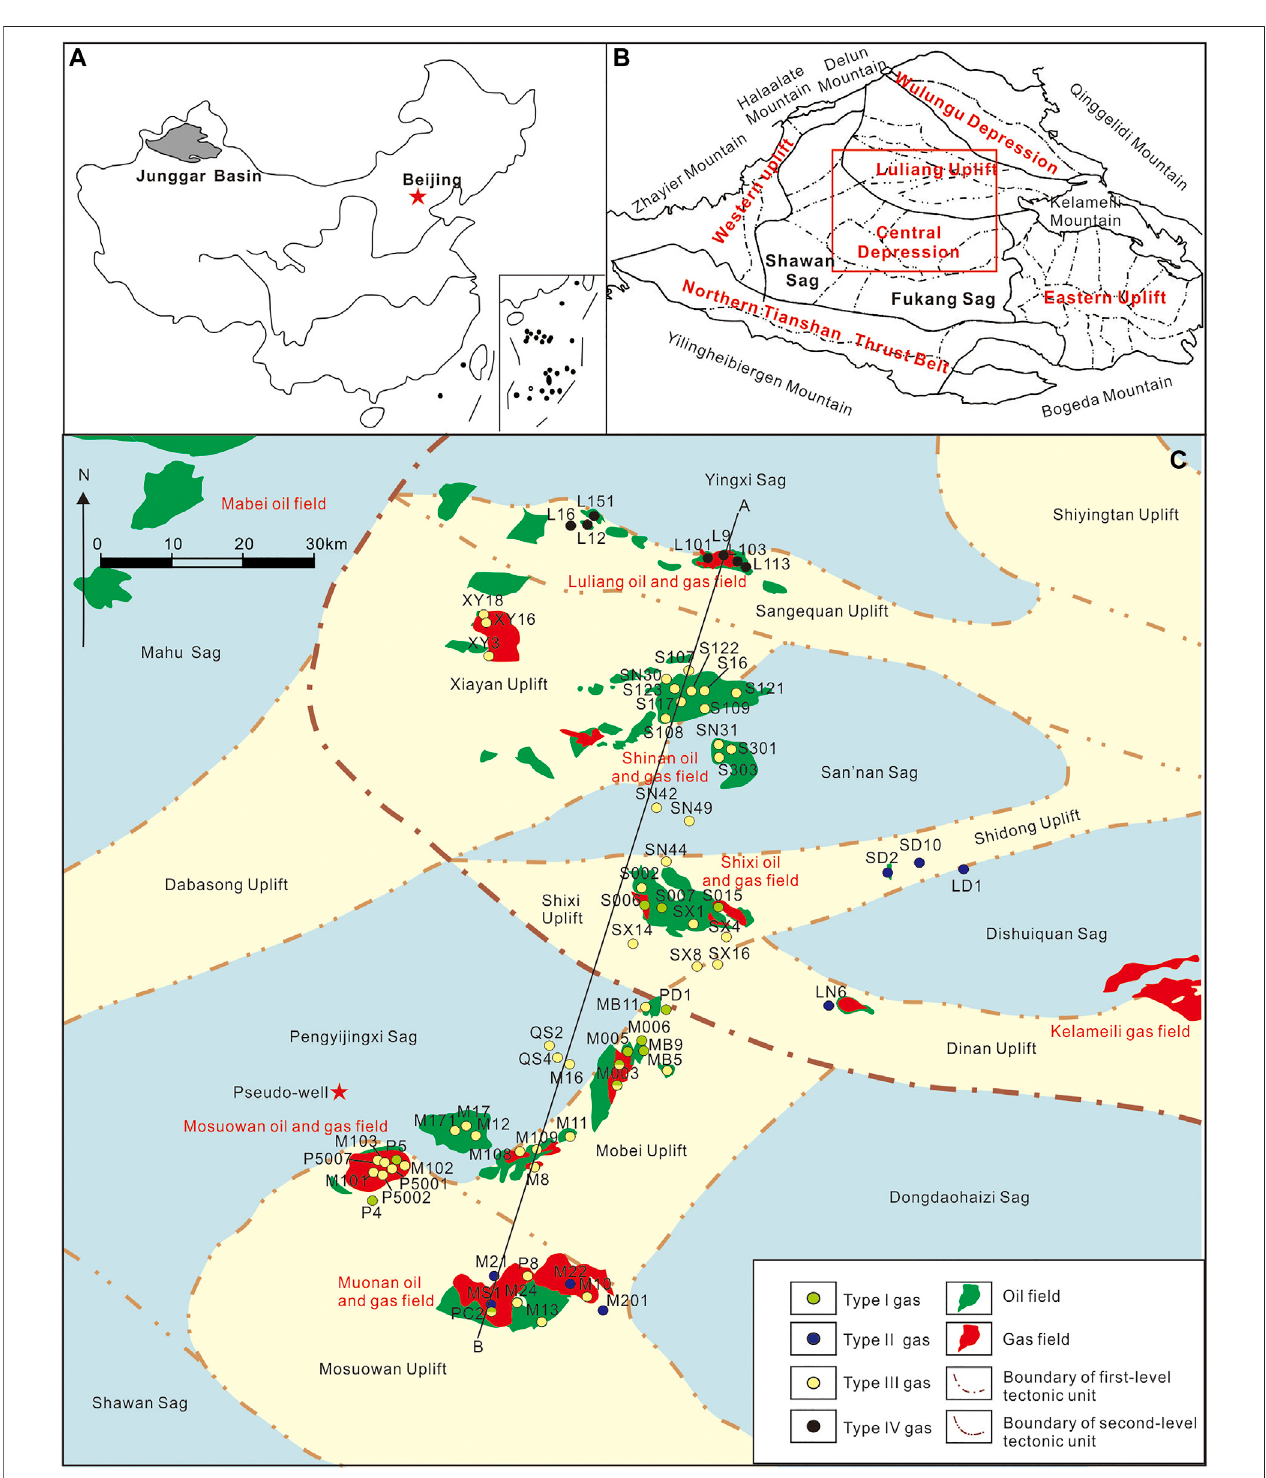
FIGURE 1 | Geological background in the hinterland of Junggar Basin. (A) Location of the Junggar Basin in China; (B) Characteristics of tectonic units in Junggar Basin; (C) Distribution of natural gas of different origins in the hinterland of Junggar Basin.